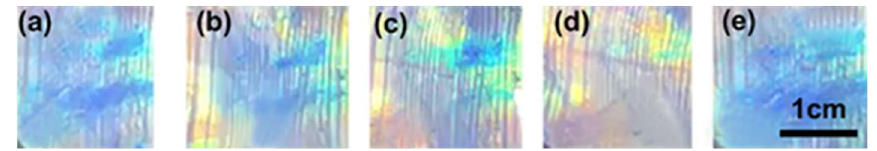
Figure 6. The structural color of the SF-PNIPAM dual-crosslinked nanocomposite film (1 mm) with different deformations ( a ) 0%; ( b ) 5%; ( c ) 10%; ( d ) 15%; ( e ) Remove external force.